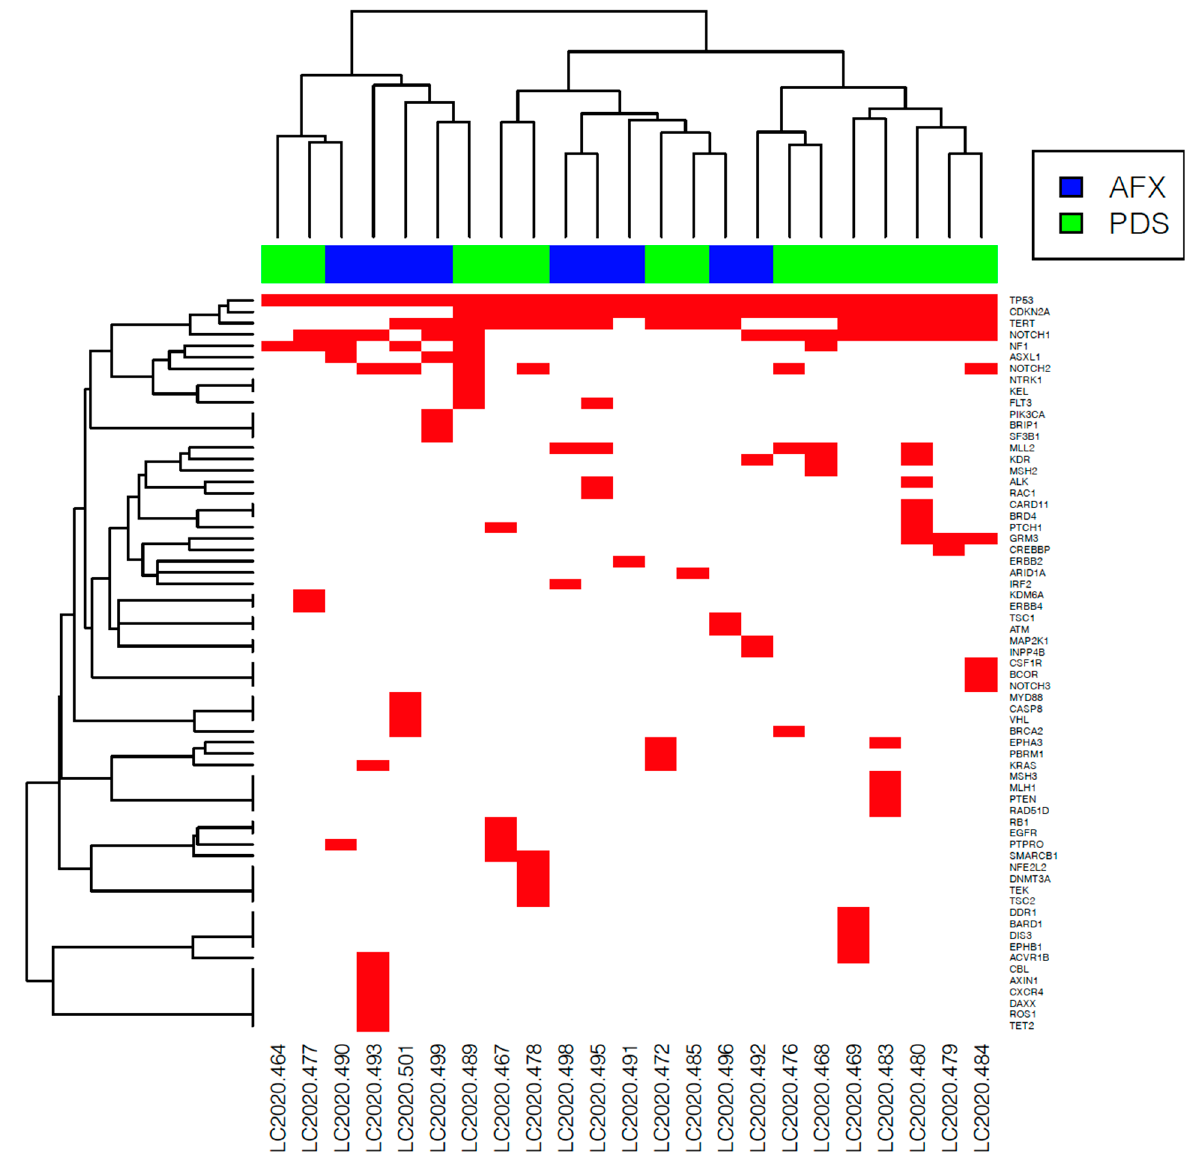
Figure 5. Heatmap of identified known and likely pathogenic gene alterations in atypical fibroxanthoma (AFX) and pleomorphic dermal sarcoma (PDS) tumor samples. The red box marks the presence of a gene alteration. The most frequent driver mutations are TP53 , CDKN2A , TERT promoter, and NOTCH1 .